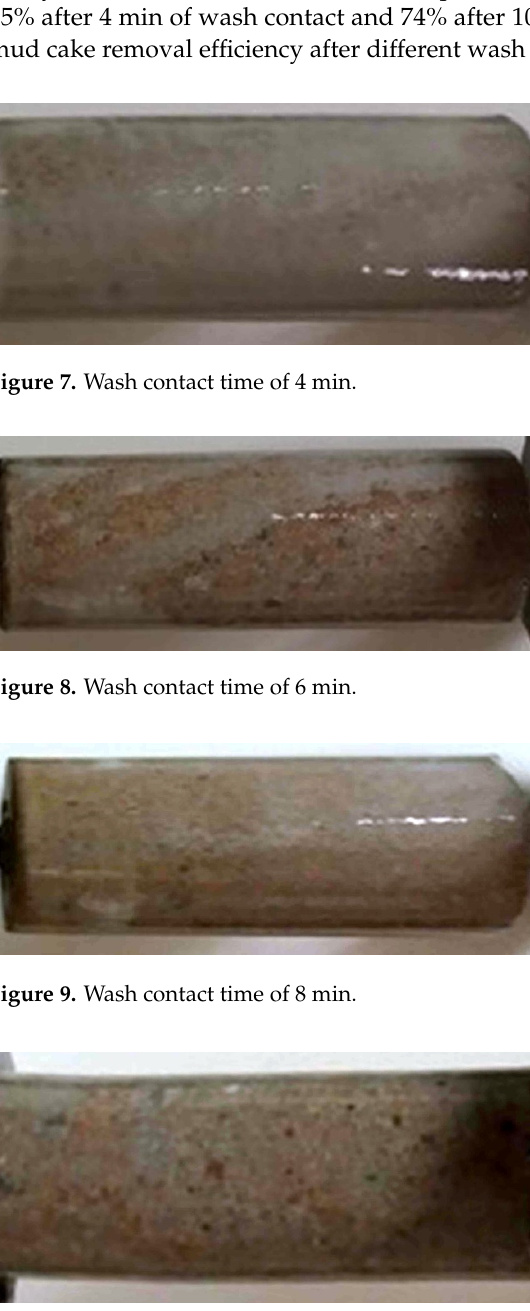
Figure 6. Values of adhesion of the hardened cement slurry to the core and the percentage improvement in mud cake removal (adhesion 2.37 = 100% mud cake removal). Results after different washing times.